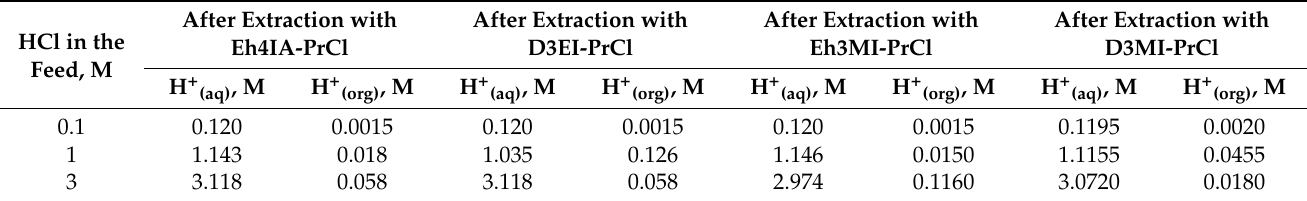
Table 5. H + co-extraction into the organic phase containing 0.005 M Eh4IA-PrCl, D3EI_PrCl, Eh3MI-PrCl, and D3MI-PrCl (feed: 2.5 × 10 − 3 M Pt(IV) in 0.1–3 M HCl). After Extraction HCl in the Feed, M